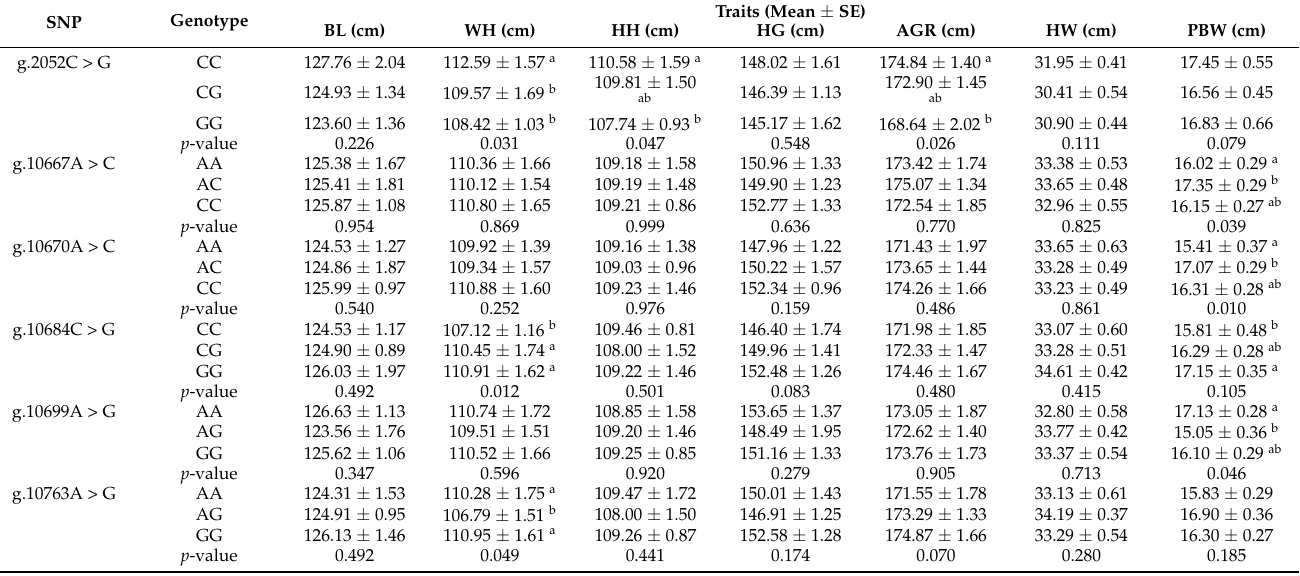
Table 6. Association analysis of SNPs with body conformation traits in Dabieshan cattle.